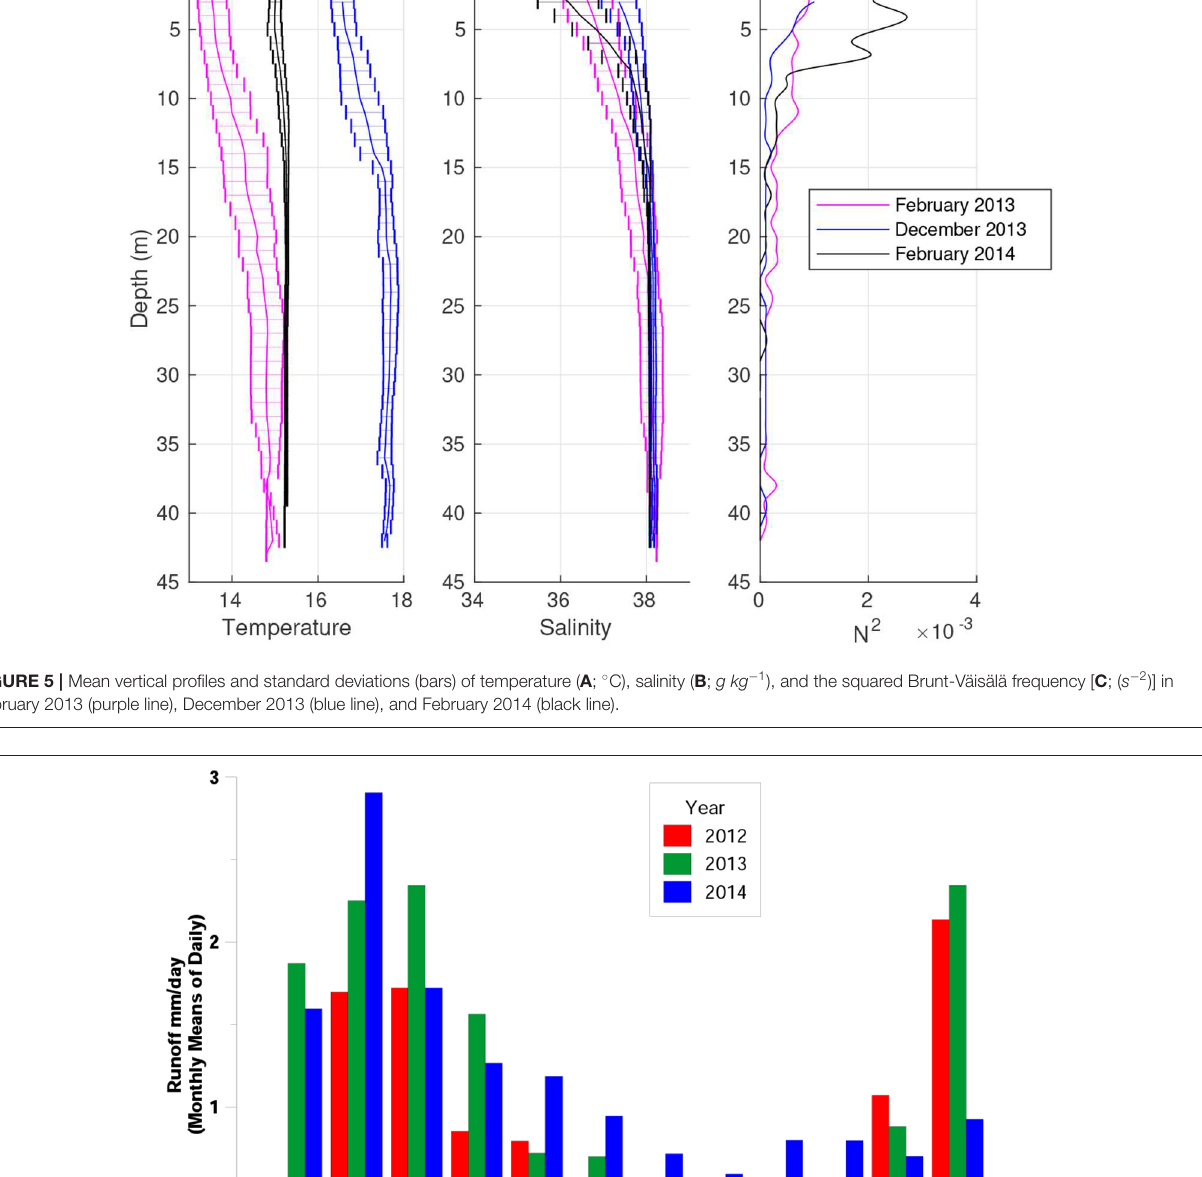
Frontiers in Marine Science |